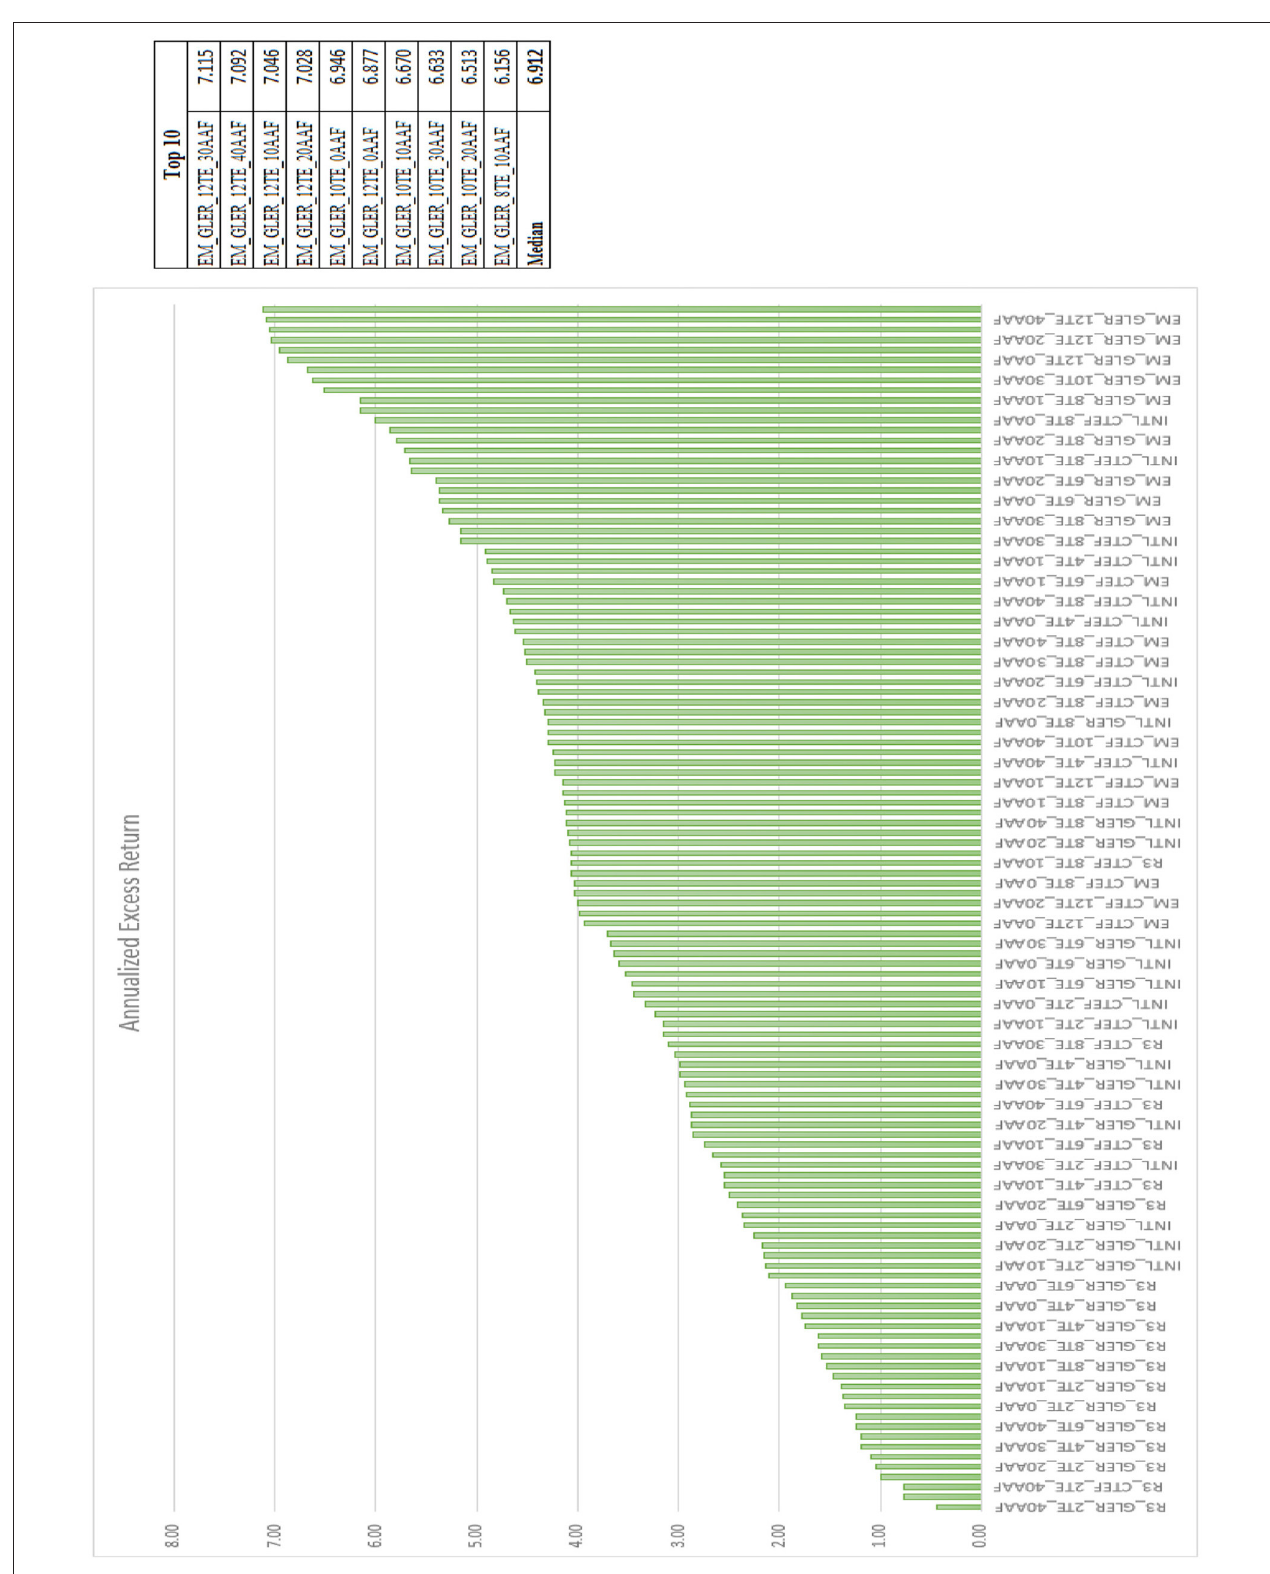
FIGURE 7 | Excess